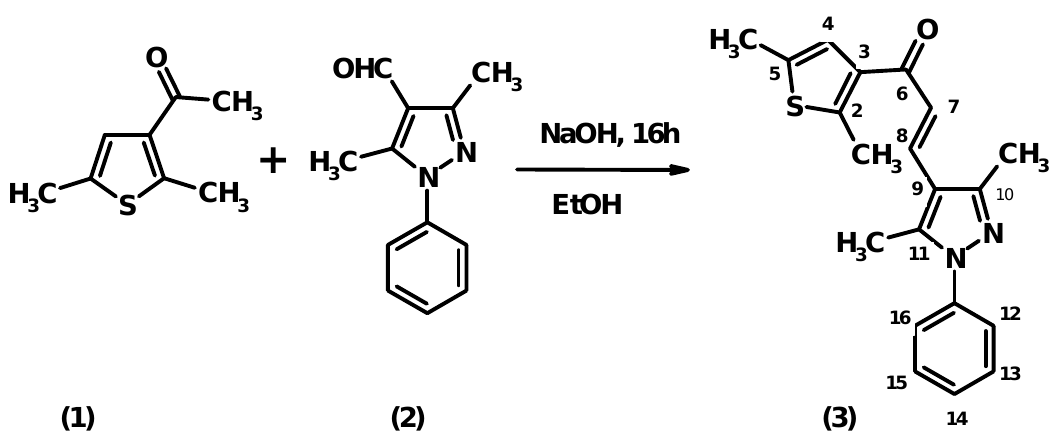
Figure 1. Synthesis of compound 3